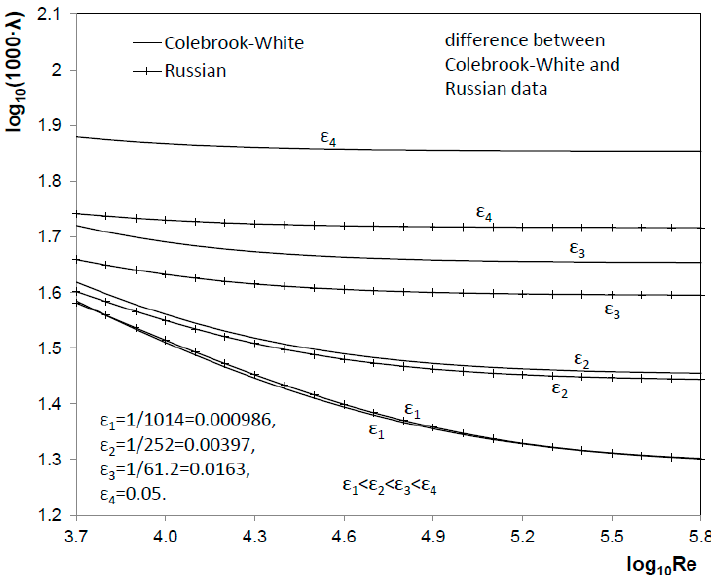
Figure 2. Different values of the flow friction factor obtained using the Colebrook formula versus the formulas from Russian practice.